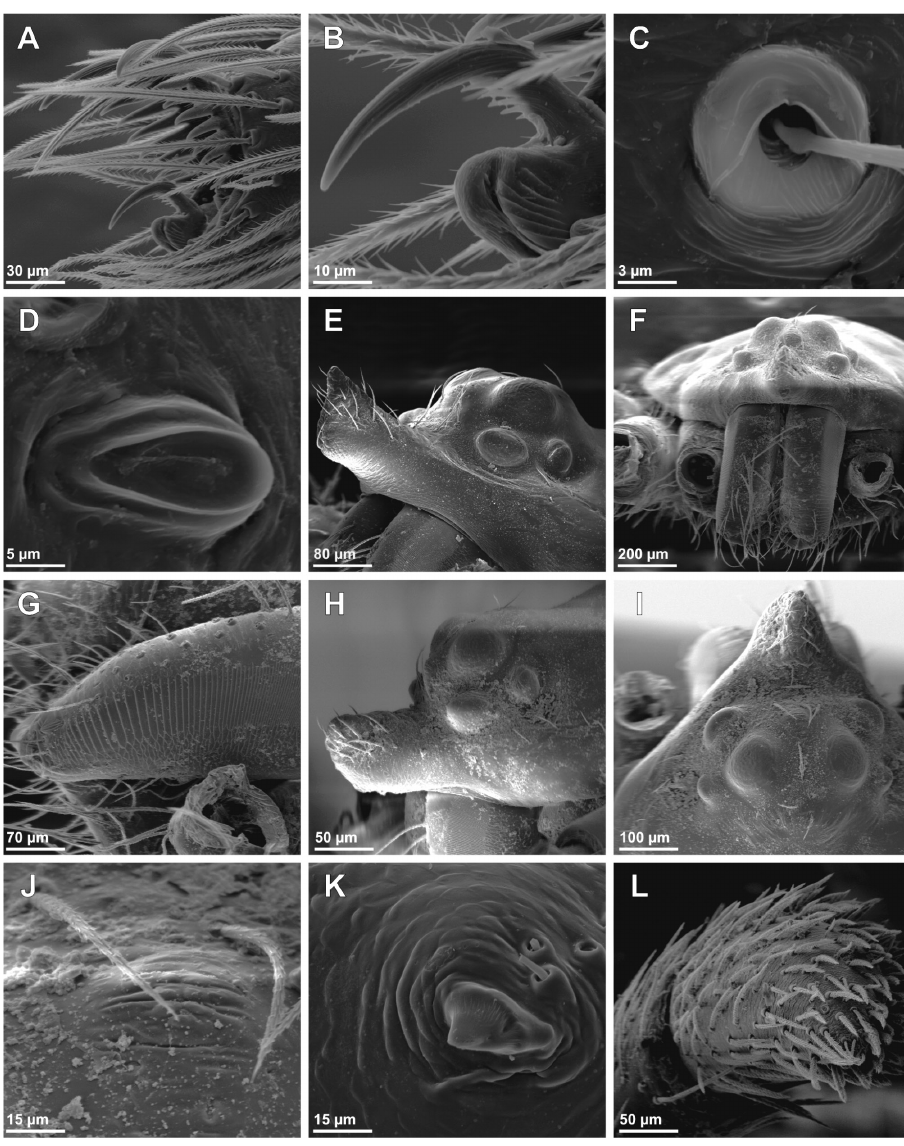
Figure 10. SEM images of Nasutonops xaxado sp. n., male ( A–D ) and female ( E–L ) from Serra Talhada, Pernambuco. A paired claws on right leg II, prolateral view B unpaired claw on right leg II, prolateral view C trichobothria base on right leg II, dorsal view D tarsal organ on right leg II, dorsal view E ocular area, lateral oblique view F same, anterior view G chelicerae, stridulatory area, lateral view H clypeal pro- jection, lateral view I same, dorsal view J striated area between posterior eyes, detail, dorsal view K stridu- latory pick on left pedipalp, prolateral view L distal area of left pedipalp, anterior